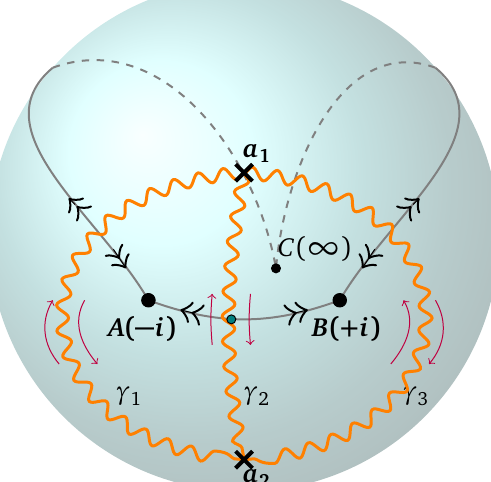
< q < 1 the N punctures localize along the Figure 5.5: In the large N limit, for 1 2 critical Strebel graph which are three cuts of the Strebel differential γ , γ and γ 1 2 3 between a and a , drawn by orange wavy lines, with the fractions ( 1 − q ) , ( 2 q − 1 ) 1 2 and ( 1 − q ) respectively. This localization is due to the attractive forces of “charges" A , B and C on those N punctures along the homotopically equivalent Jordan arcs connecting these charges as shown by the double arrows. The choices of the branches and directions for three contour integrations in (4.46) are shown by purple